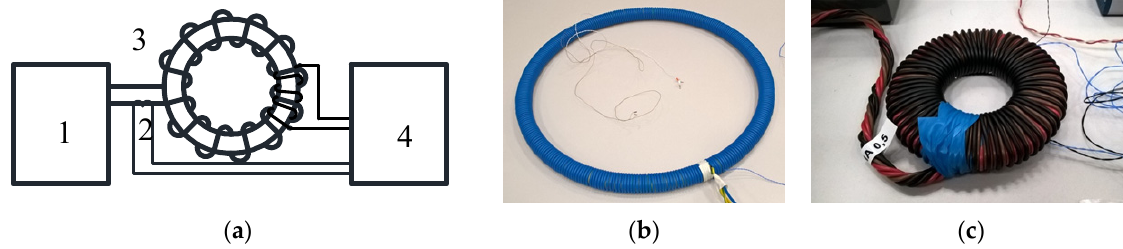
Figure 10. Experimental setup for the core loss measurements with a ring specimen ( a ): 1—power supply 100 VA frequency range: from 20 Hz to 20 kHz, 2—current transducer, 3—sample wound with magnetizing and measuring windings, 4—data acquisition and processing unit; ring specimen width 10 mm ( b ); ring specimen width 30 mm ( c ).